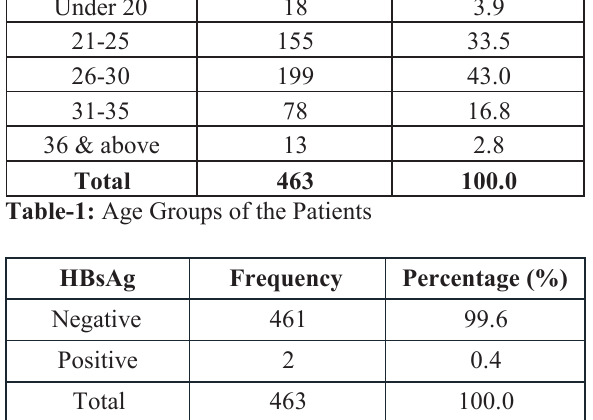
Table 2: Frequency and Percentage of HBsAg in Study Participants